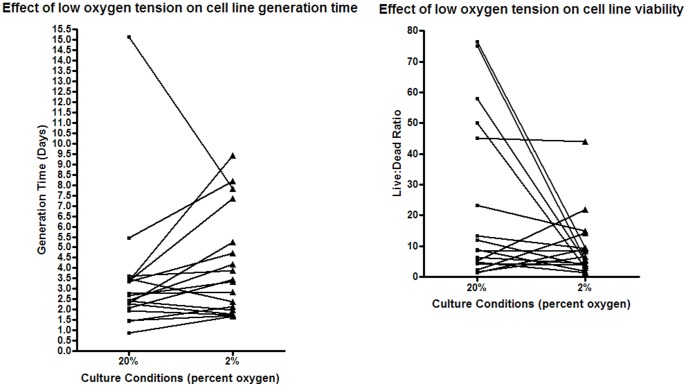
Effect of low oxygen culture on melanoma cell line generation time and viability.Eighteen melanoma cell lines were cultured under identical conditions in 2% and 20% O2 for five days. Following the culture period, the cell lines were harvested and living and dead cells enumerated using trypan blue. Total number of living cells was used to calculate generation time, and ratio of live to dead cells was used as a marker of cell viability.